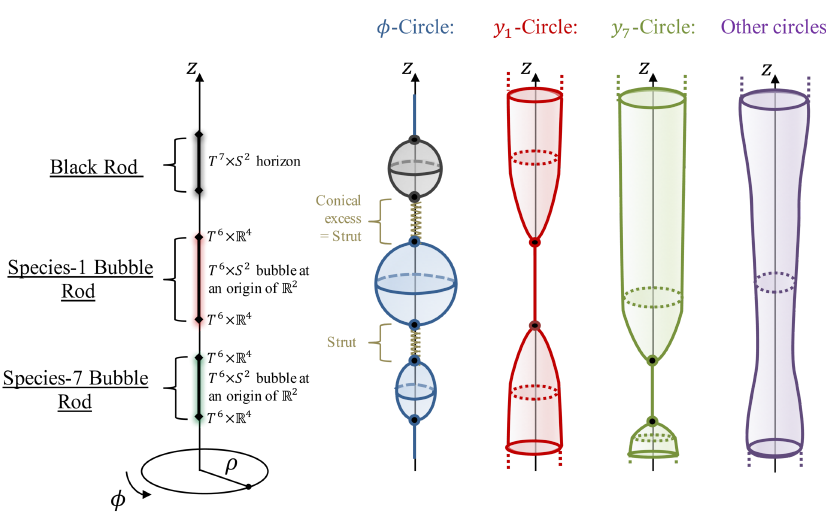
Figure 2 . Schematic description of three physical rods and the behavior of the circles on the z -axis when the rod are disconnected. The black rod sources a static M2-M2-M2-KKm black hole with a T 7 × S 2 horizon. The species-1 bubble rod corresponds to the degeneracy of the y a T 6 × S 2 M2-KKm bubble The species-7 bubble rod induces the degeneracy of the y T 6 × S 2 KKm bubble. Each section in between the sources has a conical excess, defining a